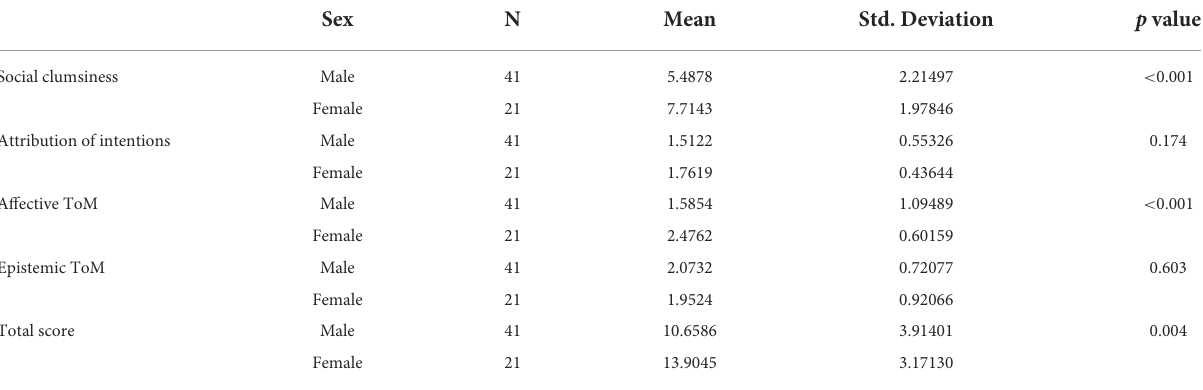
TABLE 2 Theory of Mind subdomain scores by sex. Sex N Mean Std. Deviation